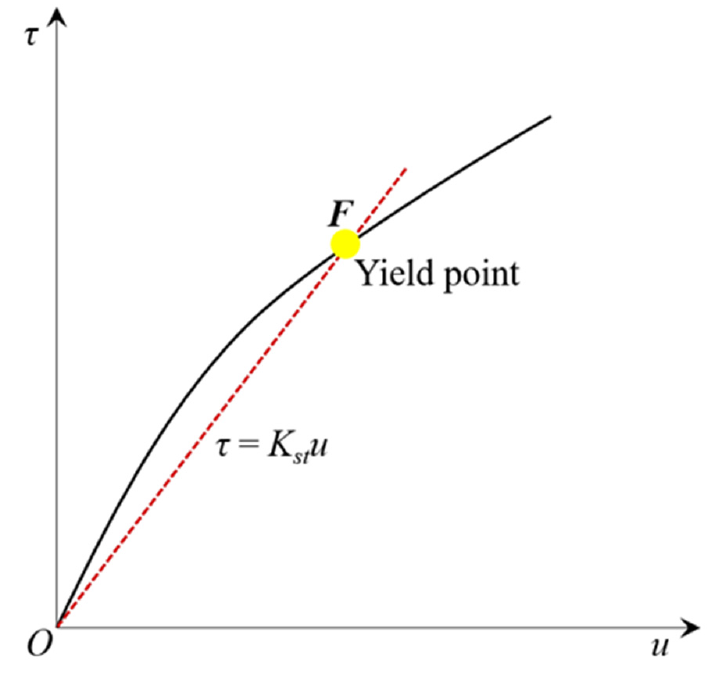
Figure 2. Schematic diagram of the shear stiffness method.